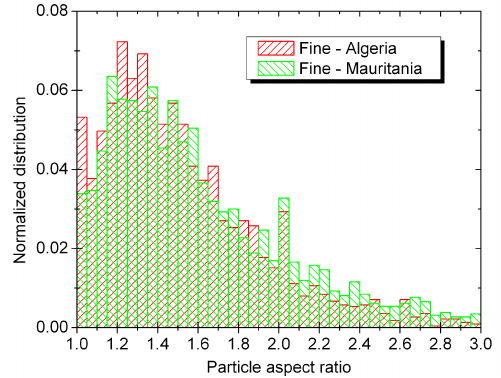
Figure 9. Particle aspect ratio distribution obtained using scanning electron microscopy (SEM) analysis for the fine-mode size distribu- tion of Saharan dust from Algeria and from group 1 in